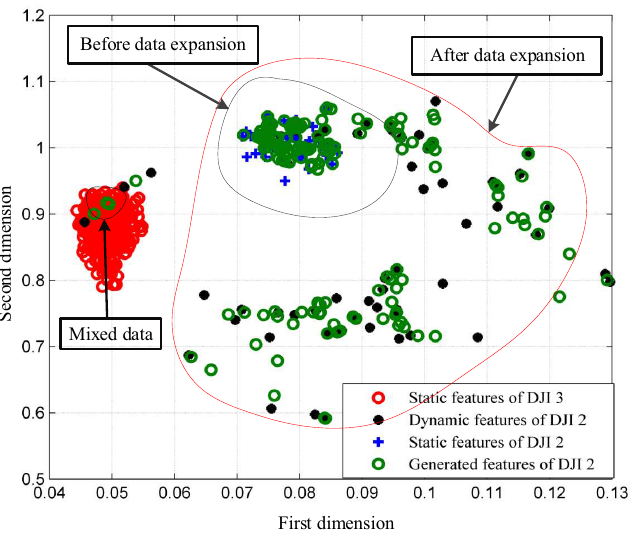
Figure 7. Distribution of generated